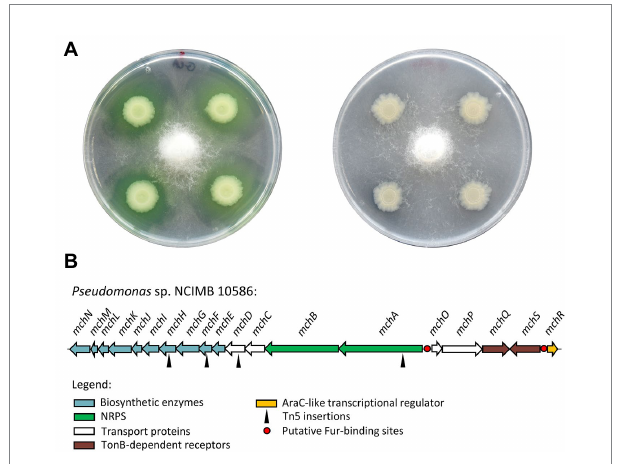
FIGURE 1 Pseudomonas sp. NCIMB 10586 growth inhibitory activity is related to iron availability. (A) Results of the antagonism assay of the ∆ AT2 mutant against G. ultimum MUCL 38045 in iron-limited (left) and iron-rich (right) medium. The mupirocin-negative mutant is still able to inhibit the growth of the phytopathogen. However, addition of 100 μ M FeCl 3 in the medium is responsible for the loss of the antagonism activity. (B) Organization of the gene cluster for the synthesis of mupirochelin in Pseudomonas sp. NCIMB 10586. Transposon insertions are indicated by black triangles. Red